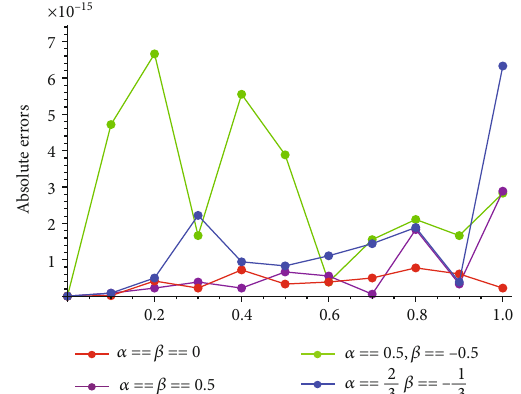
Figure 19: Comparisons between numerical and exact solutions of u 1 obtained by the present method for Example 3.